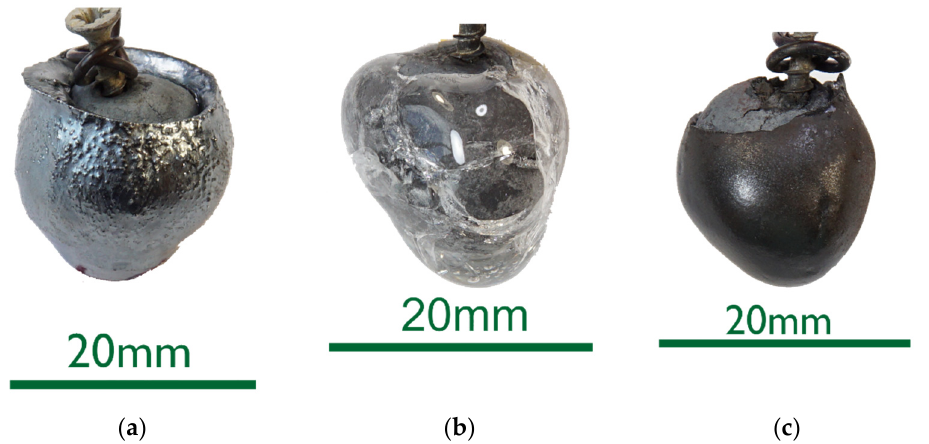
Figure 2. Macroscopic photographs of selected 0%C samples: ( a ) 0%C-ULC-1; ( b ) 0%C-SAF-1; ( c ) 0%C-EAF-2.